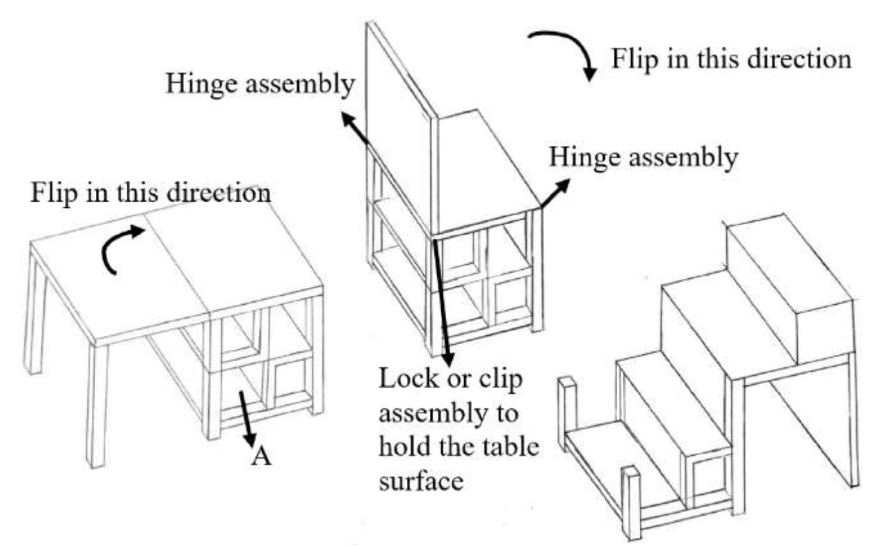
Figure 4. Hand sketch of concept